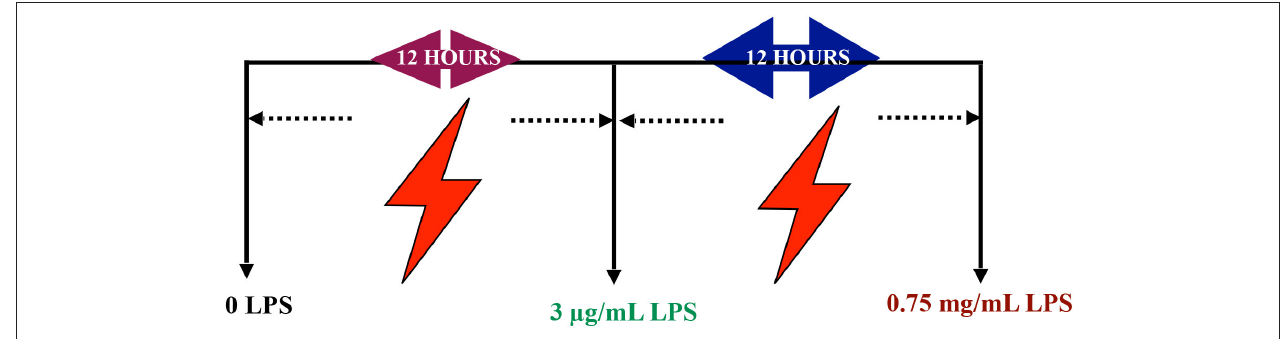
SCHEME 1 | Schematic representation of the experimental